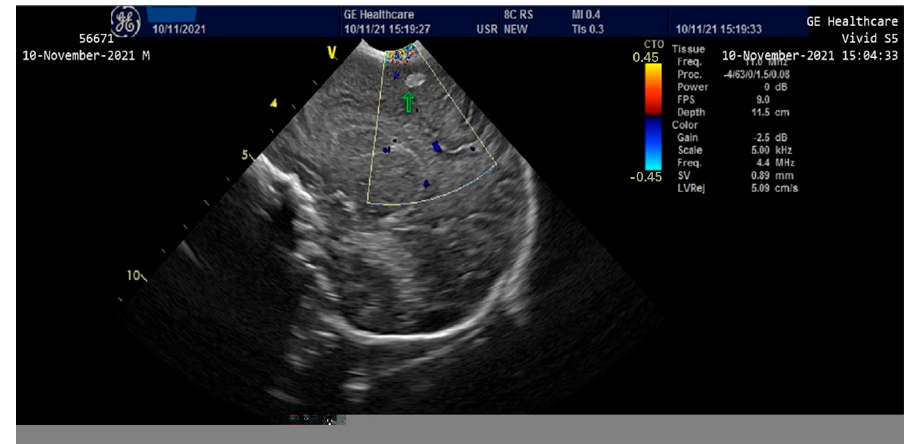
Figure 3. Cranial ultrasound in the first 24 h of life with round-oval hyperechoic image 0.6/0.4 cm in the left frontoparietal cerebral parenchyma.